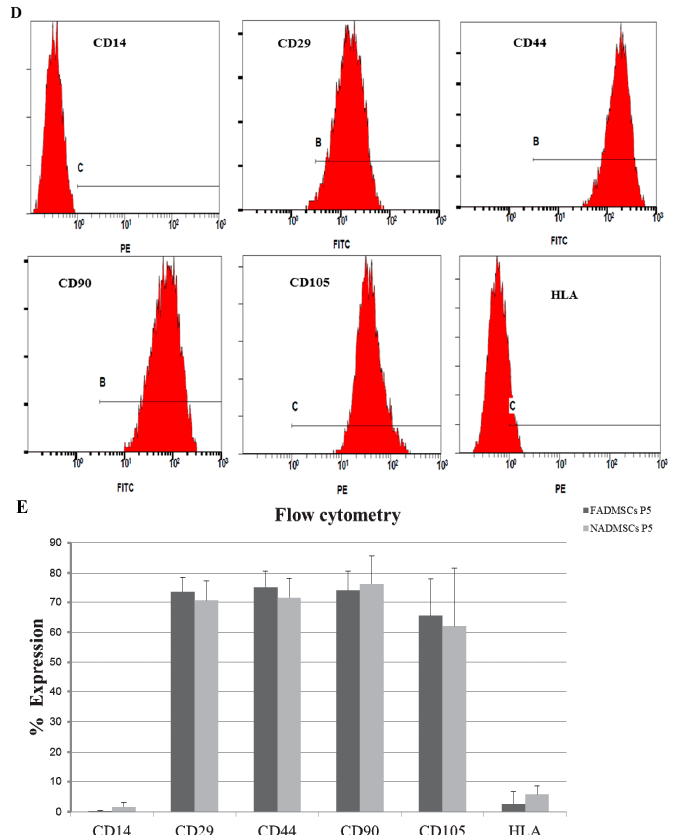
Figure 4. Surface antigen expression in ALF-derived ADMSCs and normal ADMSCs at the mRNA and protein levels. ( A ) Gene expression of surface antigens in ALF-derived ADMSCs and normal ADMSCs. The relative expression levels represent the level of expression normalized to GAPDH. The normal ADMSCs group was normalized to 1. Mean ± SD values are plotted; ( B ) Immunophenotype of the negative controls determined by flow cytometry using labeled antibodies; ( C ) Immunophenotype of ALF-derived ADMSCs determined by flow cytometry using labeled antibodies; ( D ) Immunophenotype of normal ADMSCs determined by flow cytometry using labeled antibodies; ( E ) Flow cytometry analysis of ALF-derived ADMSCs and normal ADMSCs revealed the negativity for hematopoietic lineage specific markers such as CD14 and HLA and positivity for mesenchymal specific antigens such as CD29, CD44, CD90 and CD105. There was no significant difference between the two groups. The results are representative of three independent experiments. Mean ± SD values are plotted.